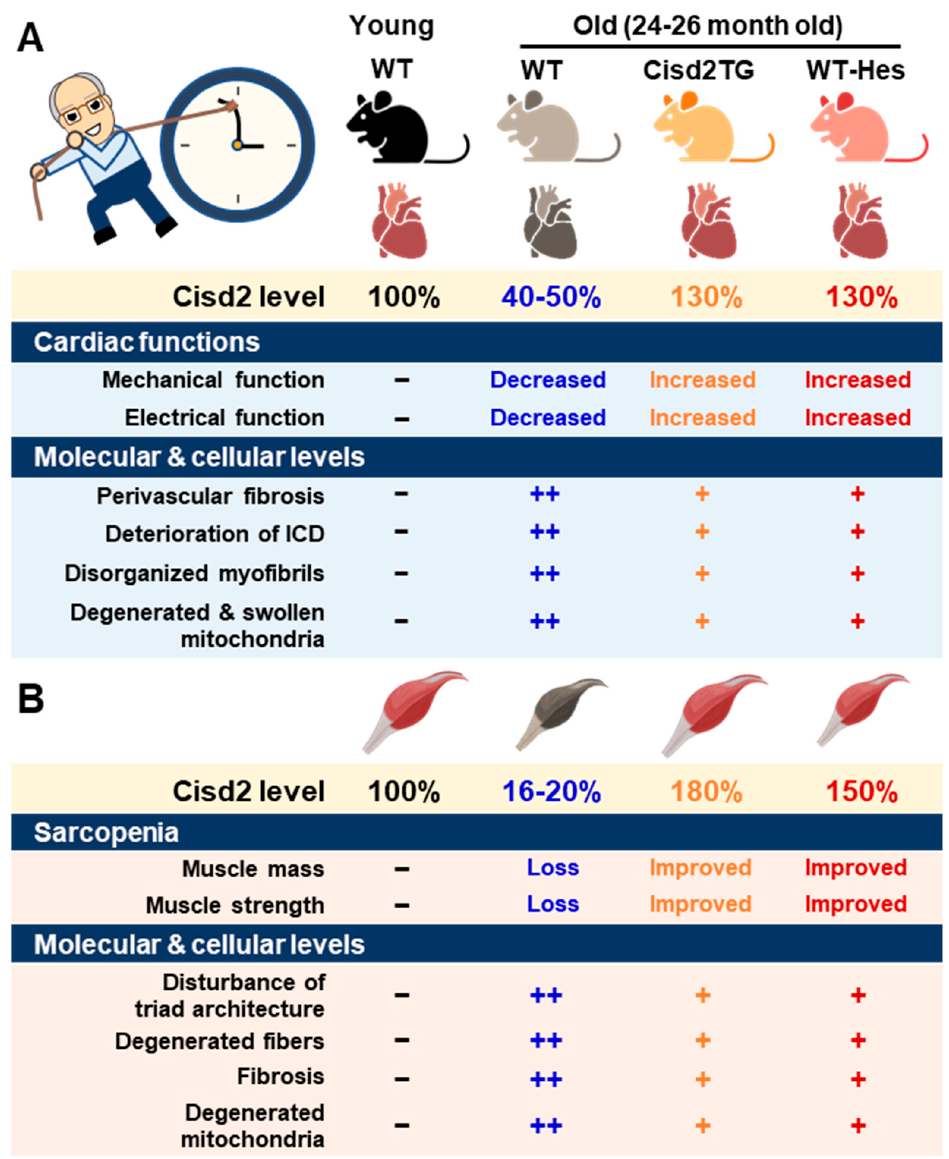
Figure 1. CISD2 attenuates heart and skeletal muscle aging. ( A ) An age-dependent decrease in CISD2 correlates with cardiac dysfunctions and molecular pathological alterations. Whole-body CISD2 overexpression (CISD2 TG) delays age-associated cardiac damage. In addition, the CISD2 activator, hesperetin (Hes), reverses age-associated cardiac damage via the activation of CISD2. ( B ) Age-dependent CISD2 reduction leads to sarcopenia and pathological alterations. Maintaining a high level of CISD2 by transgenic overexpression, or by hesperetin treatment, is able to protect skeletal muscle from age-related pathological and molecular damage. The figure was created with